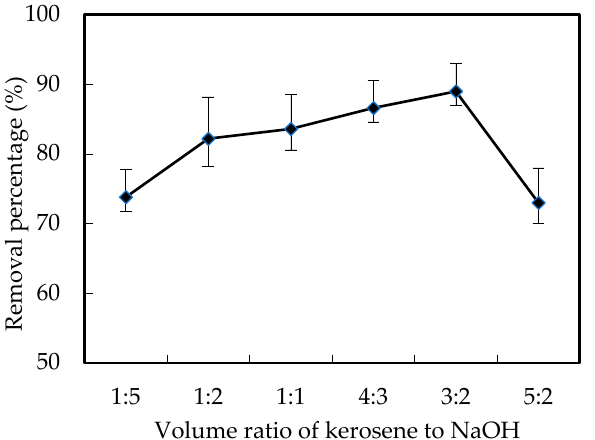
Figure 4. Effects of the volume ratio of kerosene to NaOH on the removal efficiency of W (VI).